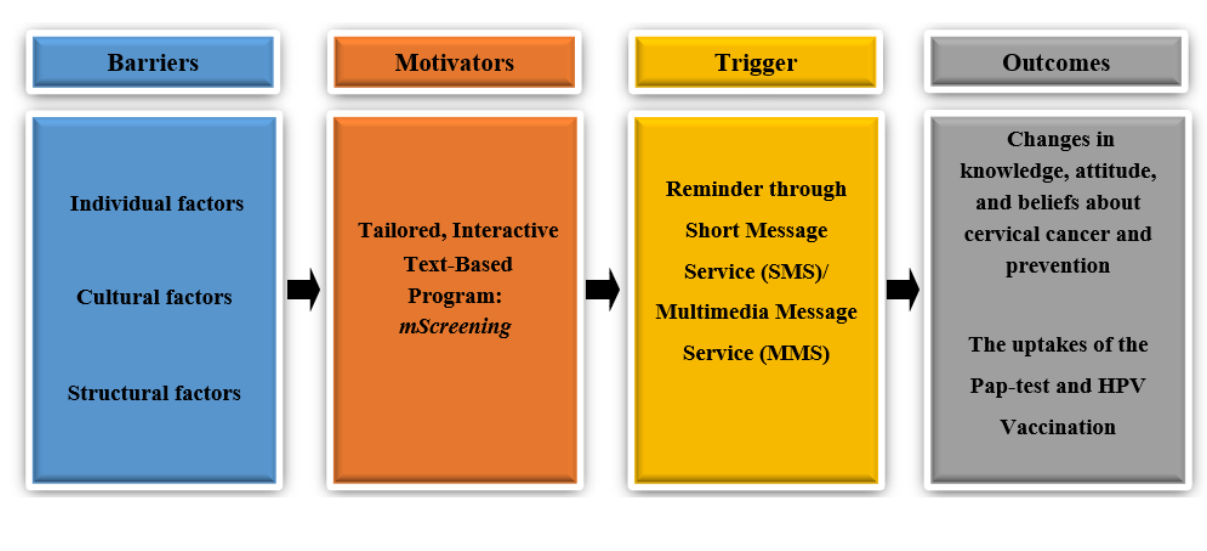
Figure 1. Conceptual